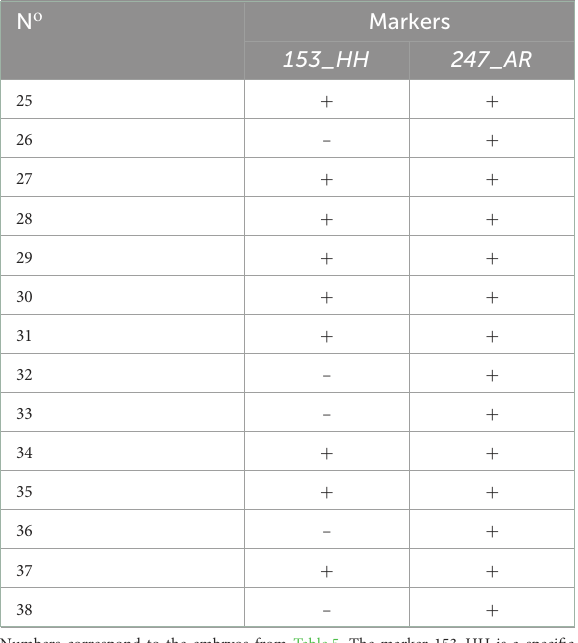
TABLE 6 Molecular analysis with species specific markers after ICSI using single cryopreserved spermatozoa from beluga sturgeon into sterlet